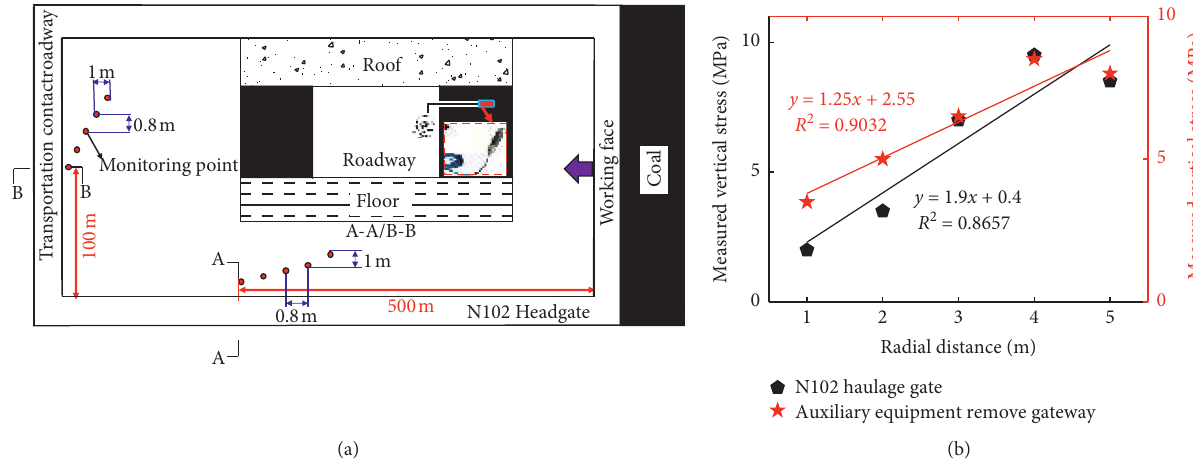
Figure 13: Layout of stress monitoring points and monitoring results. (a) Schematic layout of monitoring points (b) Monitoring results.